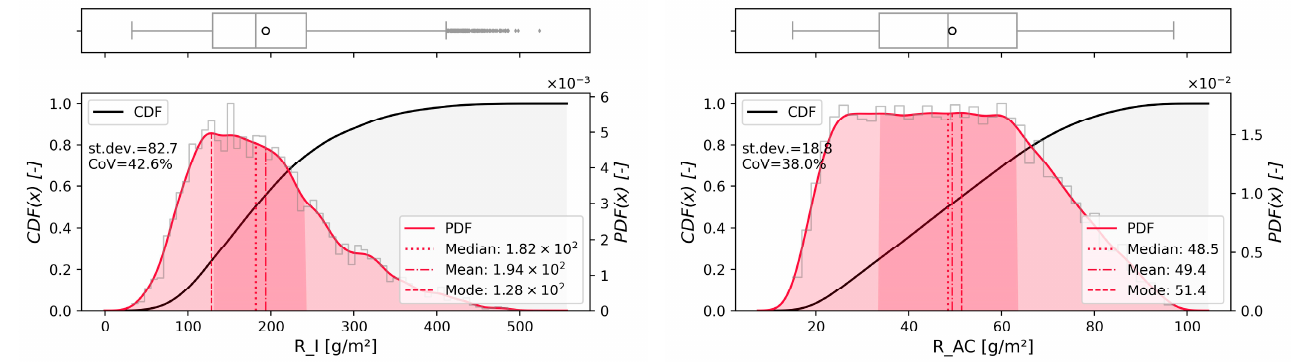
Figure 4. PDFs, CDFs, and box-whisker plots for R I and R AC .